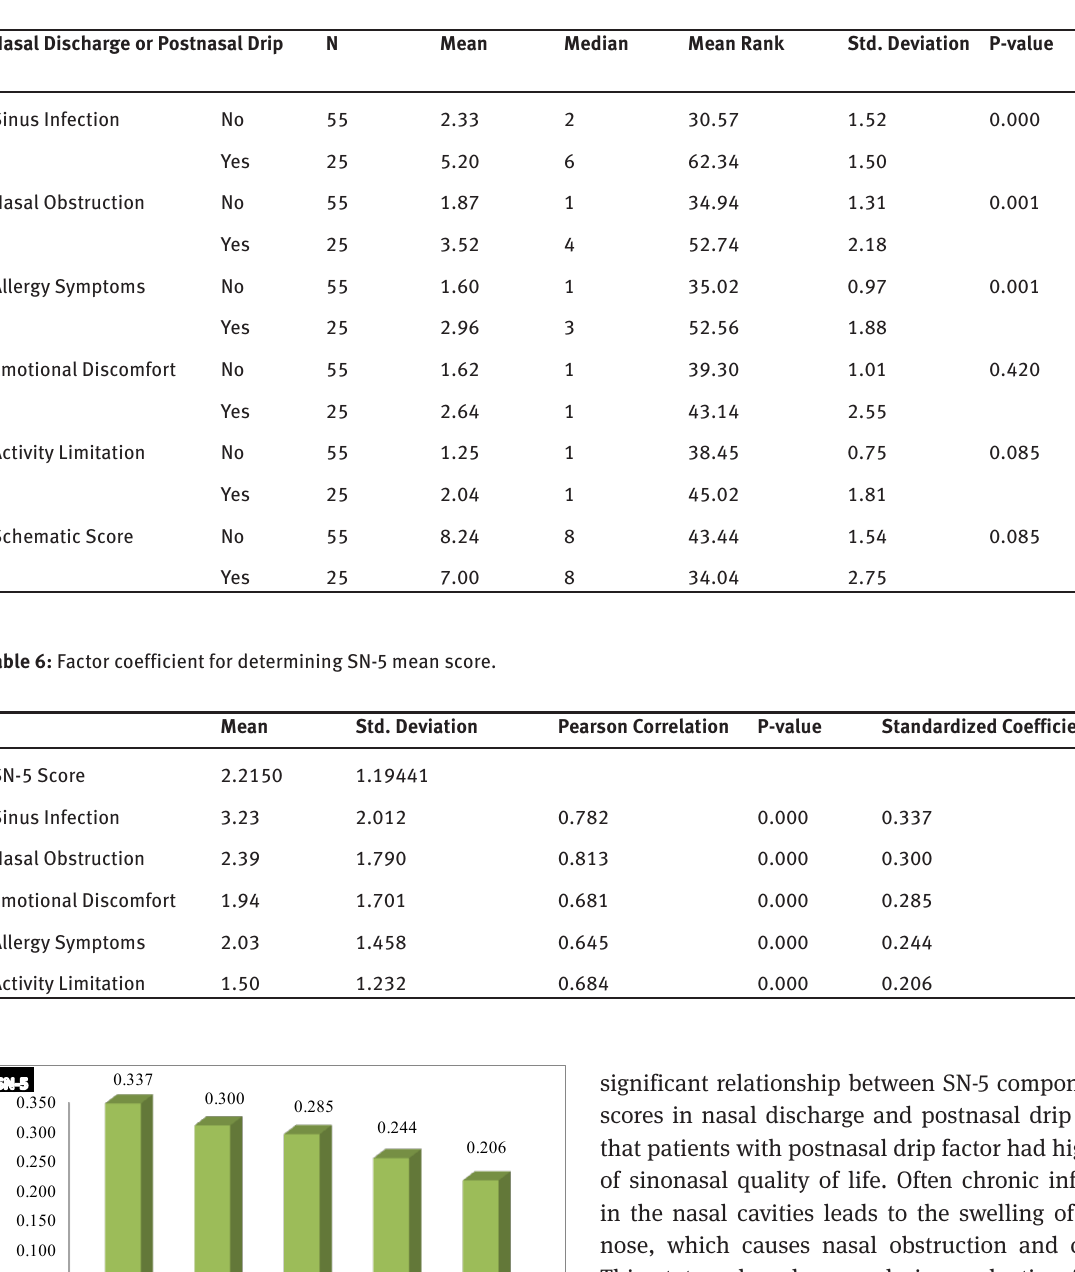
Table 5: Comparison of quality of life scores between people with Nasal Discharge or Postnasal Drip and without nasal Discharge or Postnasal Drip using the Nonparametric Mann-Whitney U test.